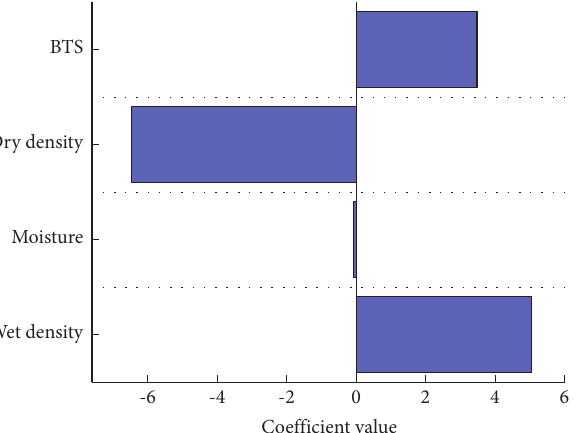
Figure 15: Sensitivity analysis of UCS